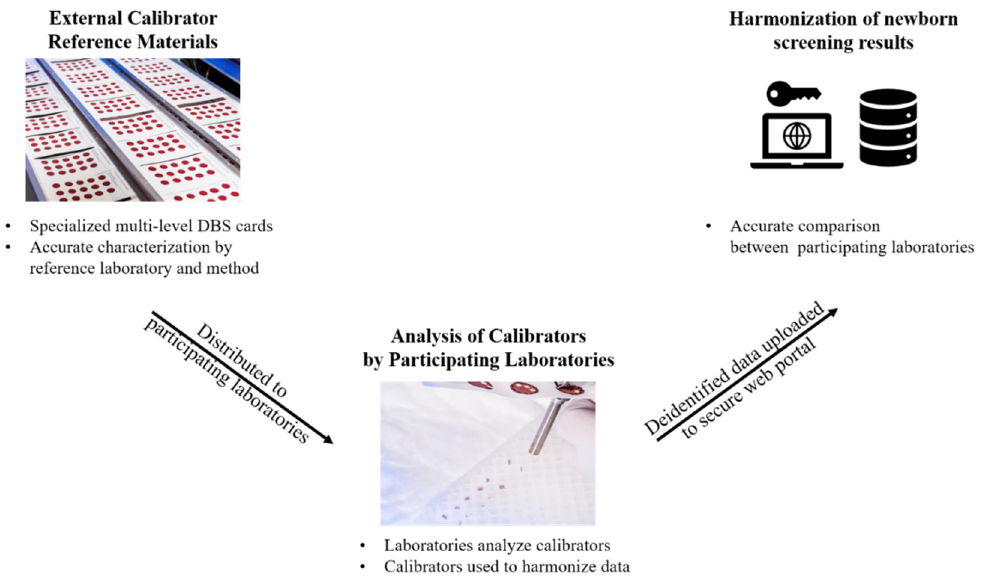
Figure 5. Proof-of-concept future harmonization workflow using external calibration. Harmonizing